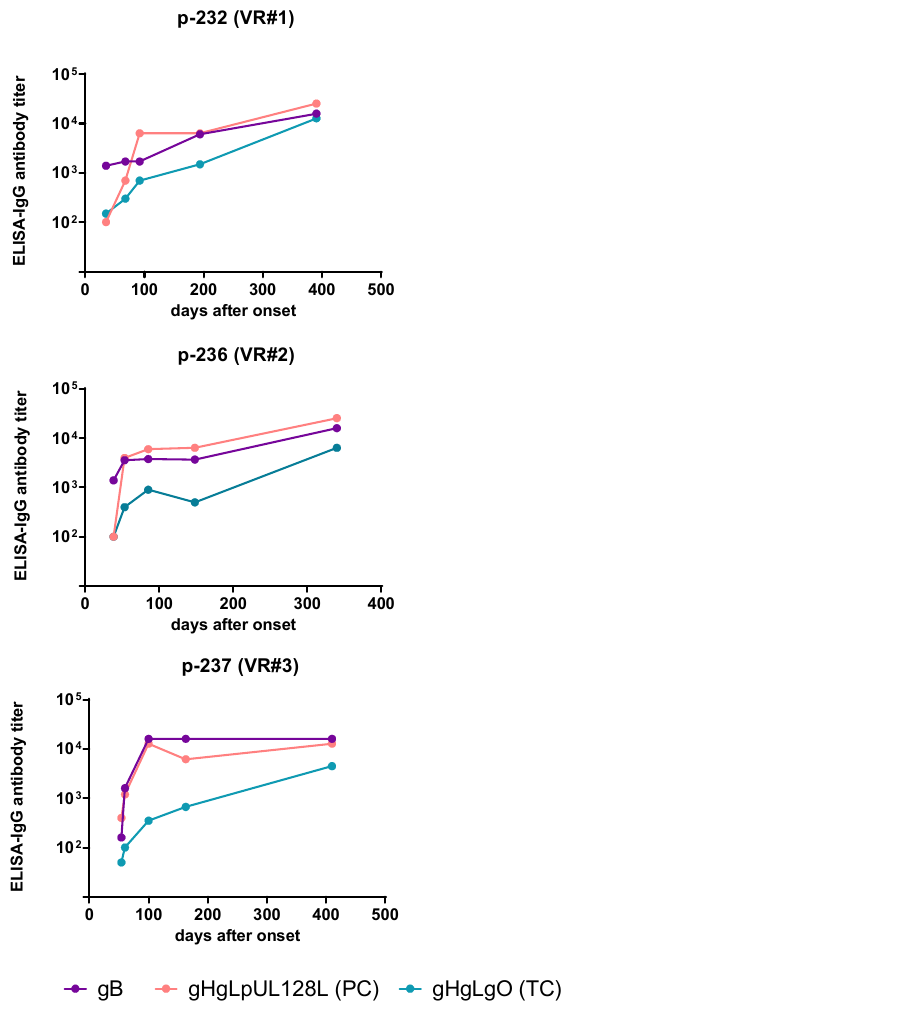
Figure 6. ELISA IgG antibody titer to gB, PC (gHgLpUL128L), and TC (gHgLgO) in five sequential serum samples collected from three pregnant women (p-232, p-236 and p-237) with PI during the first year after PI onset. For each curve, the five colored dots indicate the five time points of blood collection.